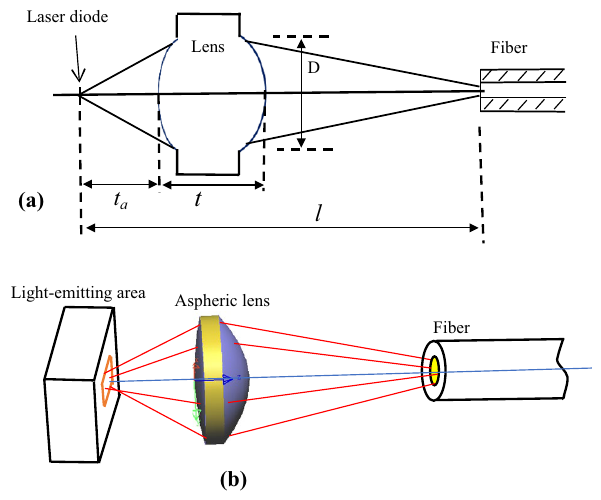
Figure 1. Schematic diagram of laser diode to optical fibre coupling configuration via aspheric lens. ( a ) The length parameters in coupling optical path ( b ) the three-dimensional map of coupling light